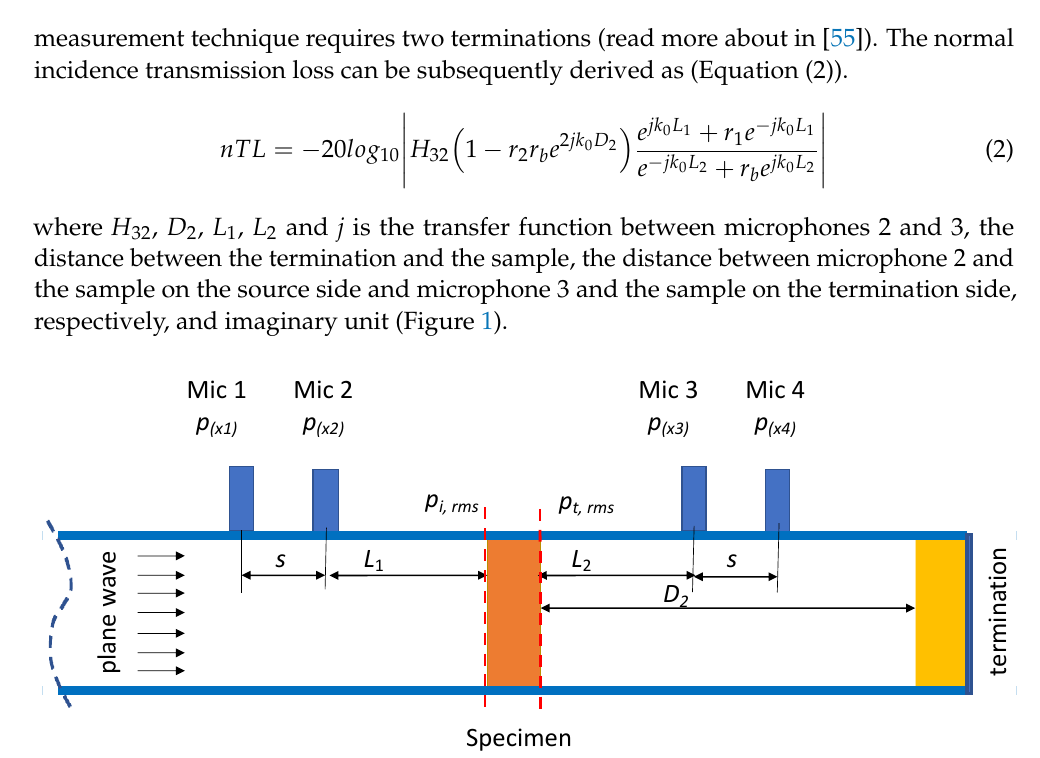
Figure 1. The scheme of the impedance tube with indication of all necessary variables to determine nTL . Upstream tube (Left), downstream tube (Right). Where p ( x 1–4) and Mic 1–4 denote the micro- phone positions, where the sound pressure is measured related to the x -coordinate, p i,rms and p t,rms are effective values of the incident and transmitted sound pressure at the surface of the specimen (derived from the measurement data p ( x 1–4) ), s is distance between microphone positions and L 1 , L 2 are distances from of the microphone to the specimen surface.